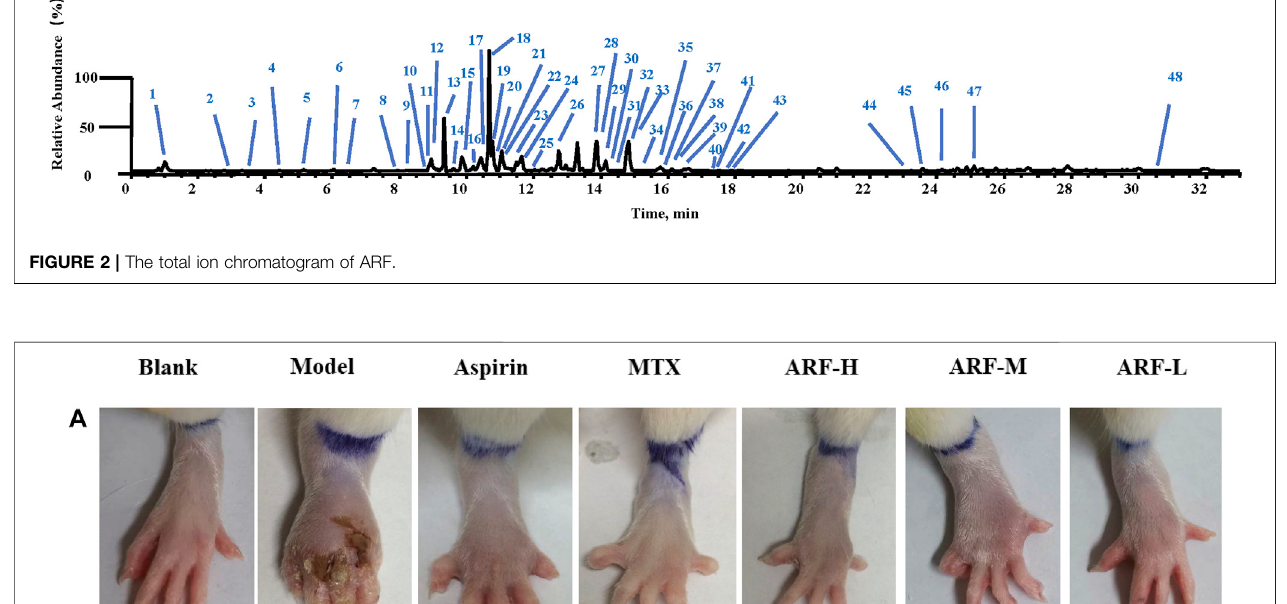
Frontiers in Pharmacology |